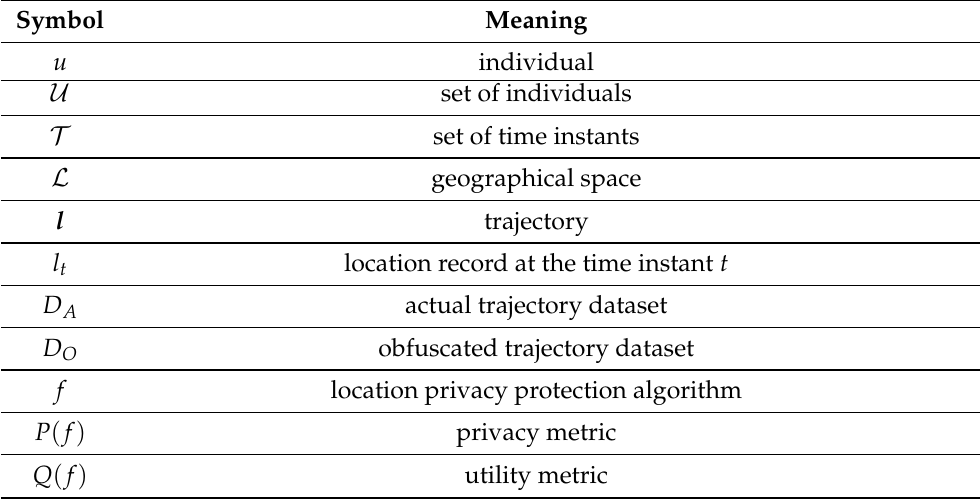
Table 2. List of